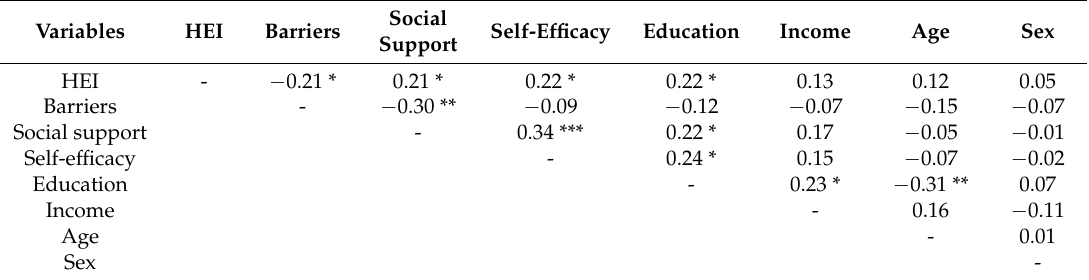
Table 6. Bivariate correlations between variables of interest and HEI scores ( n =